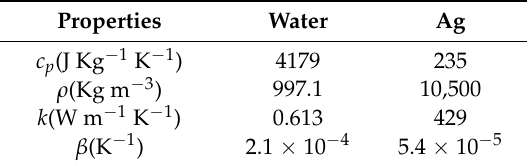
Table 1. Thermophysical properties of the water and